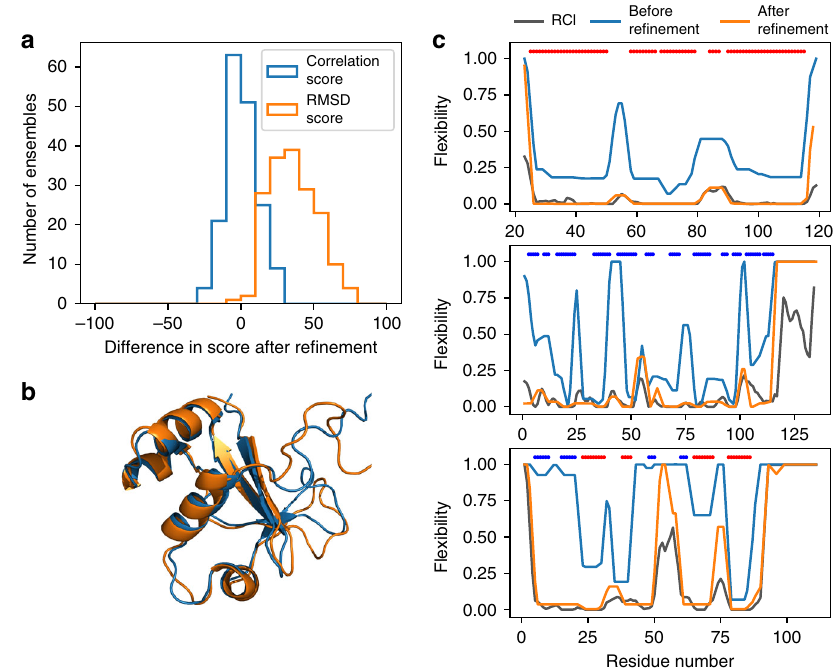
Fig. 2 The effect of explicit solvent re fi nement on the two measures of structure accuracy. a Histogram showing the change in average correlation score (blue) and RMSD score (orange), comparing ensembles from the CNS75 to the CNW75 sets. RMSD scores improve dramatically while there is no signi fi cant change in correlation scores. b Backbone superposition of CNS model 14 and CNW model 14 of the restriction of telomere capping protein 3 from S. cerevisiae (PDB ID 1nyn), as a typical example of the effect of re fi nement in explicit solvent. Although the RMSD score is much better after re fi nement, the backbones do not look very different. c Comparisons of RCI (gray) with fl exibility calculated using FIRST for representative models from CNS (blue) and CNW (orange) re fi nements. The colored bars at the top of each plot show the regular secondary structures: α -helix (red) and β -sheet (blue). The three proteins are (top) the N-terminal domain of VAM3P from S. cerevisiae (CNS/CNW model 4, PDB ID 1hs7), a largely helical protein; (middle) a single-domain antibody from Brucella (CNS/CNW model 20, PDB ID 1ieh), a largely β -sheet protein, and (bottom) the restriction of telomere capping protein 3 from S. cerevisiae (CNS/CNW model 14, PDB ID 1nyn), a mixed α / β